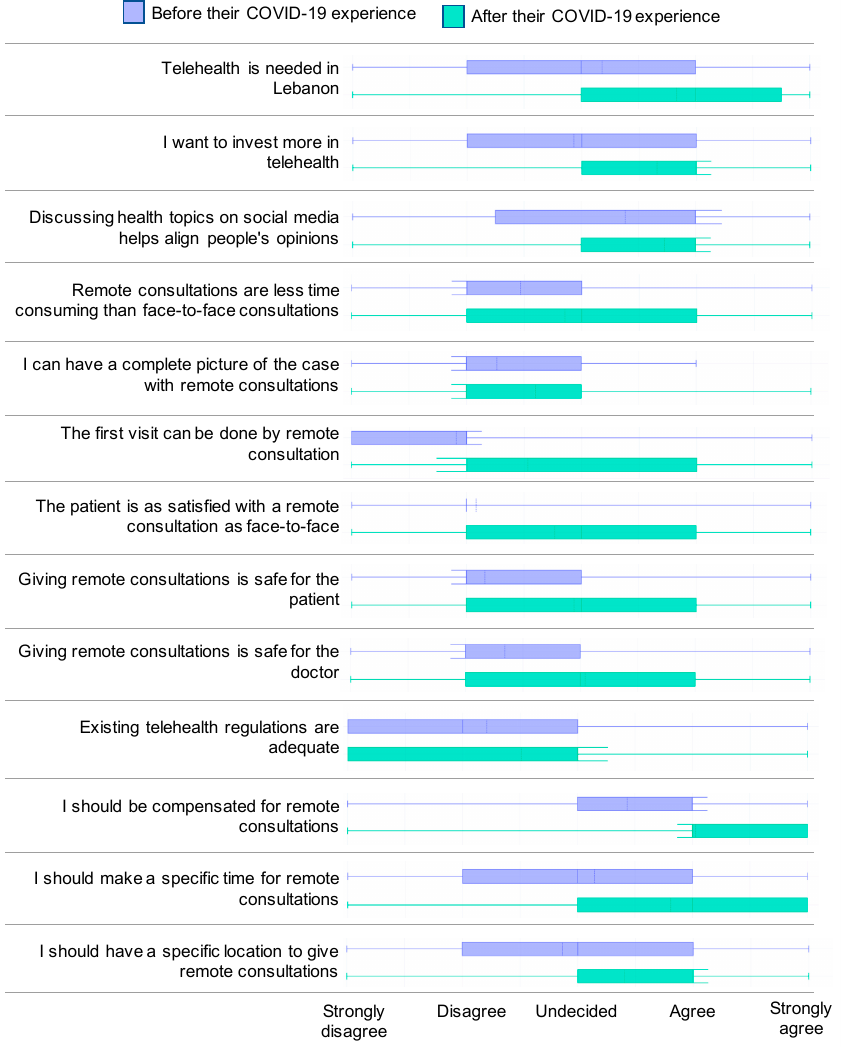
Figure 4. The e ff ect of the COVID-19 pandemic on the physicians’ perceptions regarding Figure 4 . The effect of the COVID-19 pandemic on the physicians’ perceptions regarding telehealth.